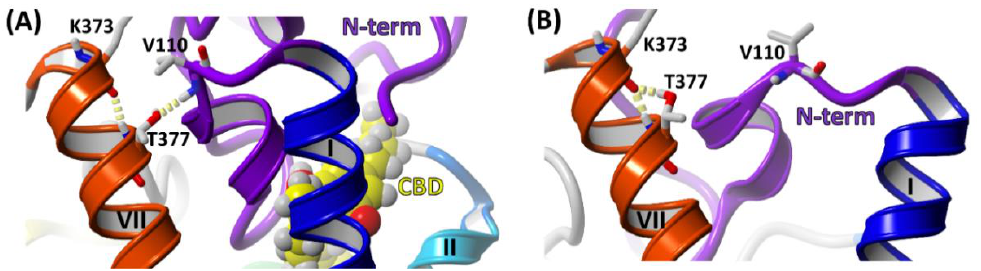
Figure 14. The molecular switch formed by residues V110 MPR -T377 7.33 -K373 7.29 as an important element of the allosteric modulation. ( A ) In CBD-THC simulations the switch exists predominantly in the configuration where a hydrogen bond V110 MPR -T377 7.33 (side chain-main chain) is formed; ( B ) in THC-only simulations the hydrogen bond of side chain of T377 7.33 is much more often formed within the same helix VII to K373 7.29 (side chain-main chain).